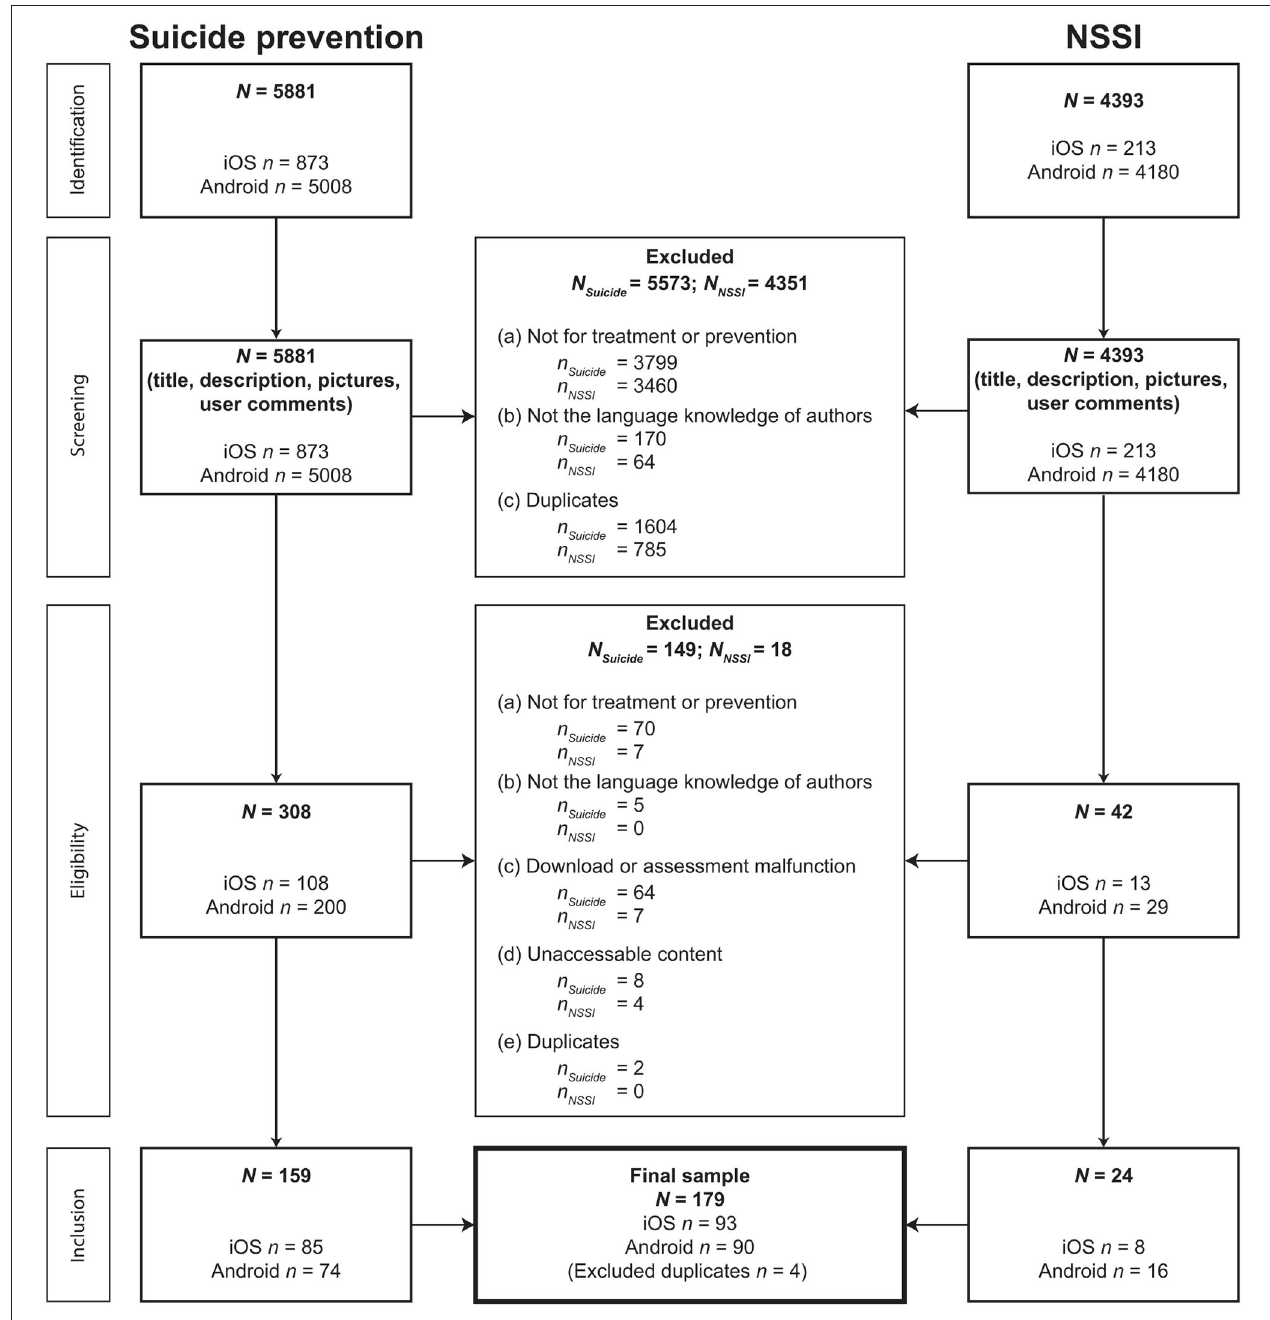
FIGURE 1 | Flowchart of the app inclusion